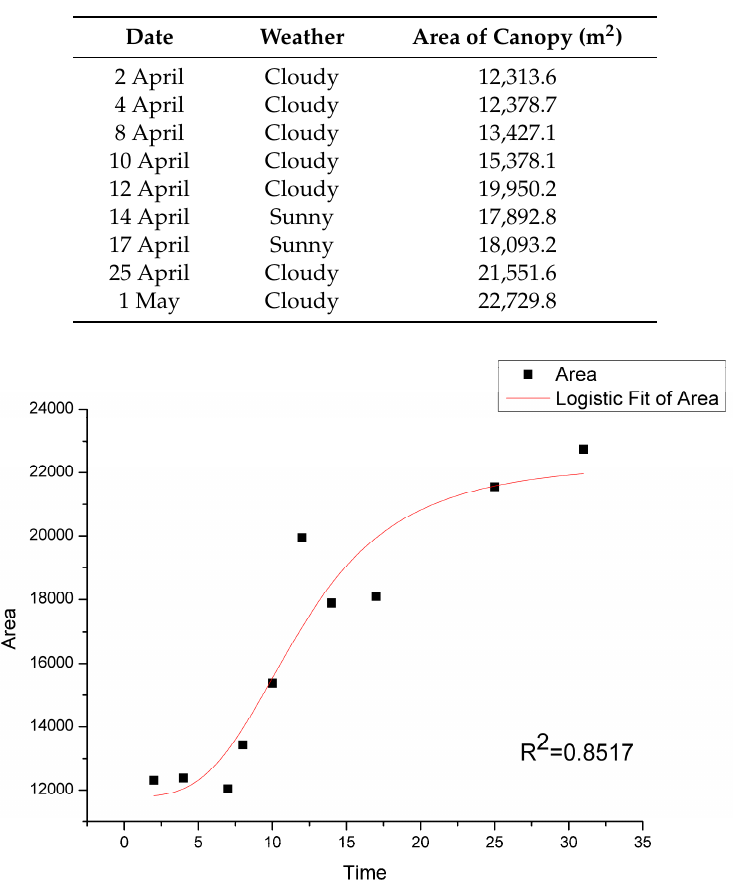
Figure 8. The graph of logistic fitting of the canopy area in the whole study area from 2 April to 1 May 2019. Table 2. Summary of the results of logistic fitting.